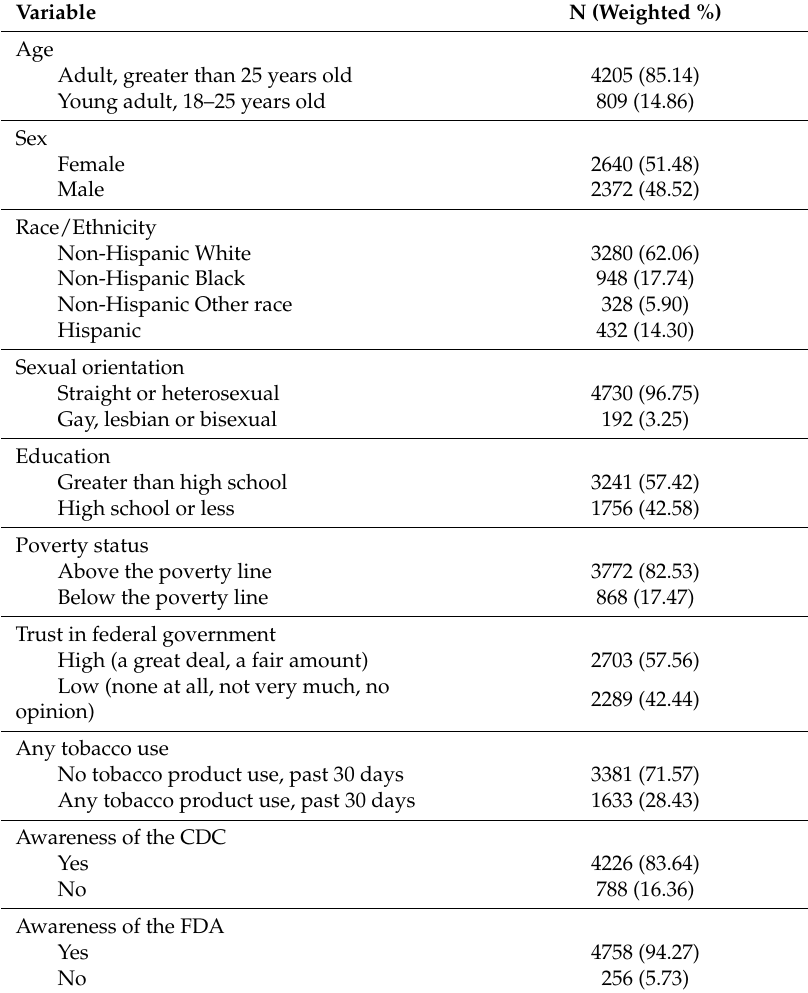
Table 2. Weighted participant characteristics, n =